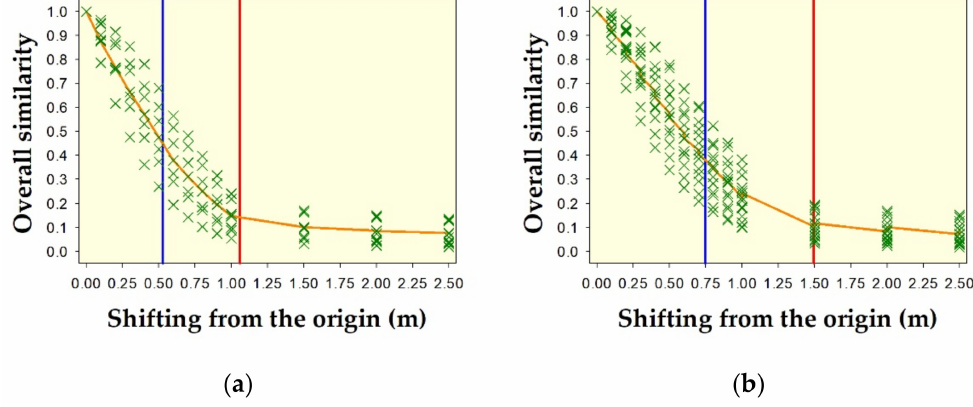
Figure 18. Overall spatial pattern similarity (i.e., the average of similarity of θ and similarity of δ ) of two hypothetical shapes: ( a ) circle with diameter of about 1.0567 m and ( b ) square with dimensions of 1.0567 × 1.0567 m 2 , due to shifting from the origin in all directions. Green crosses indicate overall similarity from all 10 metrics. Orange lines in the middle of the envelopes indicate overall similarity using the new metric of Ruzicka–Fidelity (Equation (1)). Vertical blue lines indicate half size of the maximum radii of the shapes, while vertical red lines indicate the maximum radii of the